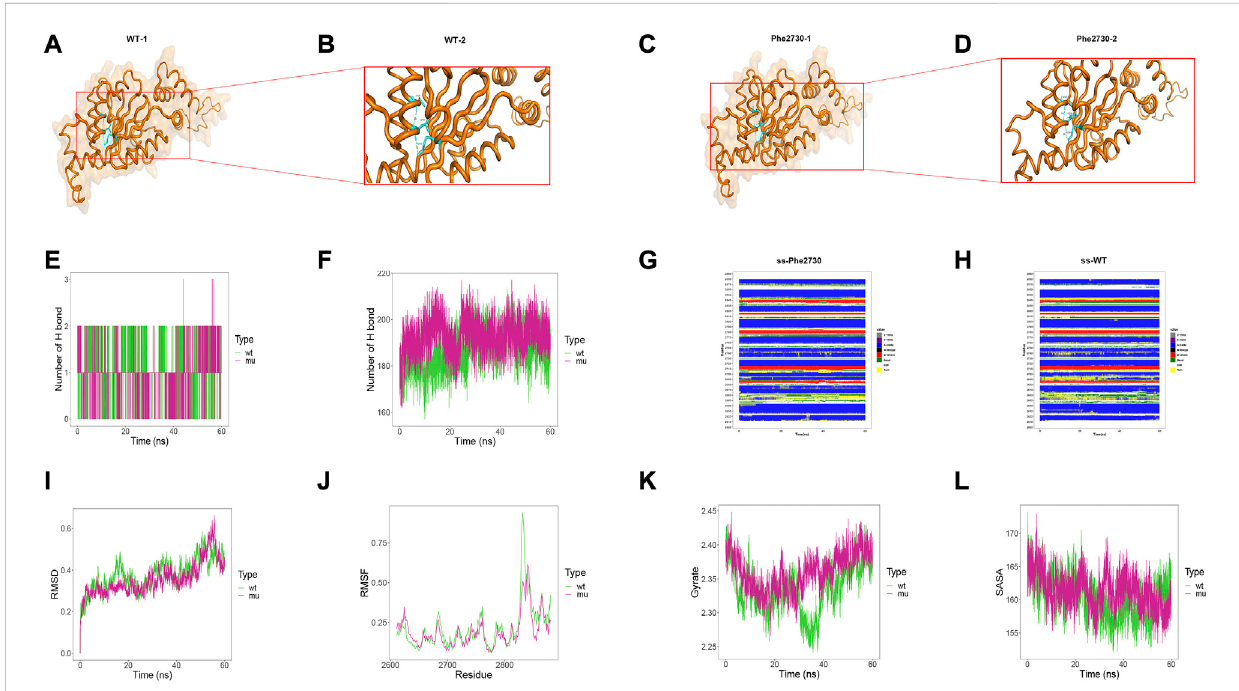
FIGURE 5 ResultsofstructuralanalysisandmoleculardynamicssimulationofDYNC2H1:c.8190G > T(p.Leu2730Phe)variation. (A,B) Thewild-typestructureof DYNC2H1: protein (DYNC2H1), and enlarged image of the segment containing Leu2730 residue. (C, D) The mutant structure of DYNC2H1, and segment containing the variant Phe2730 residue. (E) The number of hydrogen bonds formed between the target amino acid (meaning Leu2730 or Phe2730) and other residues. (F) Total number of hydrogen bonds in the wild-type model and the mutant model, respectively. (G, H) Comparison of local secondary structure data between Leu2730Phe mutant and wild-type. (I) RMSD: a numerical measurement indicating the difference between two structures. (J) RMSF: is a numerical measure similar to RMSD, but instead of indicating differences in position over time between entire structures; it calculatesthe fl exibilityofindividualresidues,ortheextenttowhichaparticularresiduemoves( fl uctuates)duringasimulation. (K)